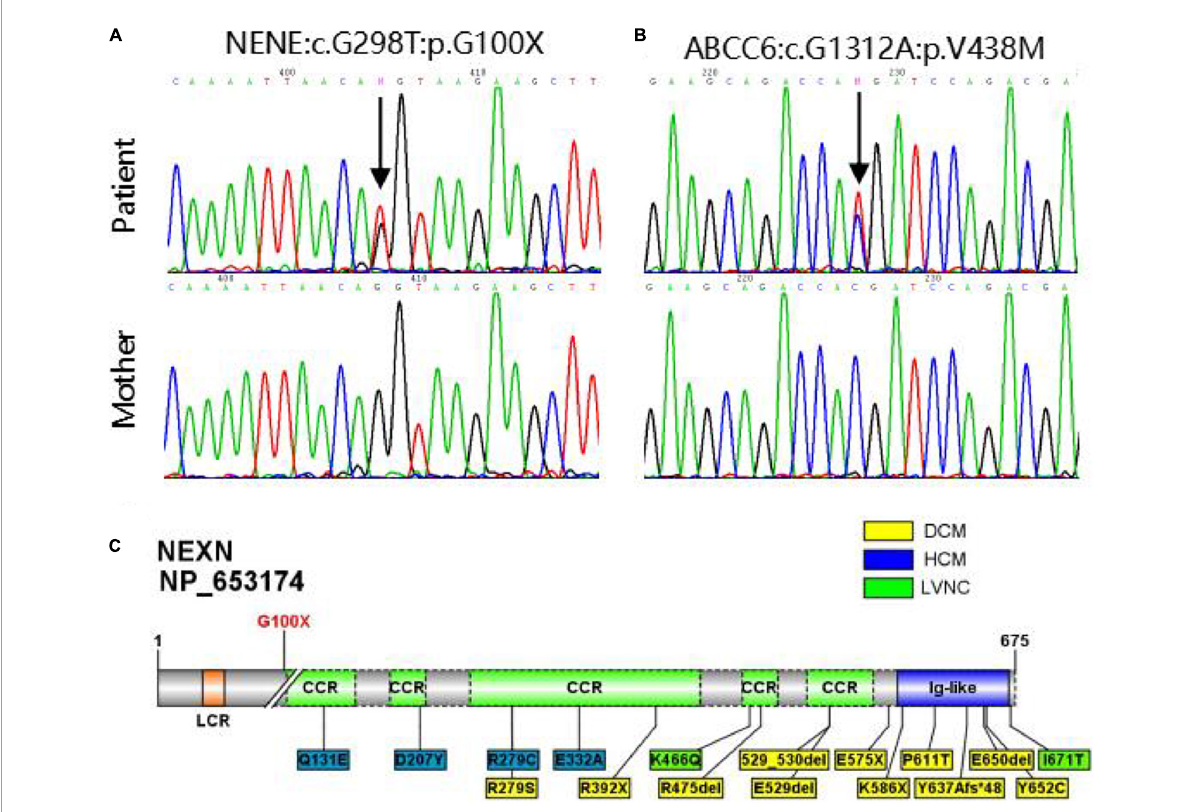
FIGURE2 (A,B) Sanger sequencing validation of NEXN variant and ABCC6 variant in the patient and his mother. (C) Diagram of NEXN protein with the location of variant identified in this study (upper). All 17 variants in NEXN (NM_144573, NP_653174) previously reported cardiomyopathy patients are included in the schematic (underneath). The yellow and blue boxes indicate that the patient has dilated cardiomyopathy (DCM) and hypertrophic cardiomyopathy (HCM), respectively, and the green one indicates that the patient has left ventricular non-compaction (LVNC).